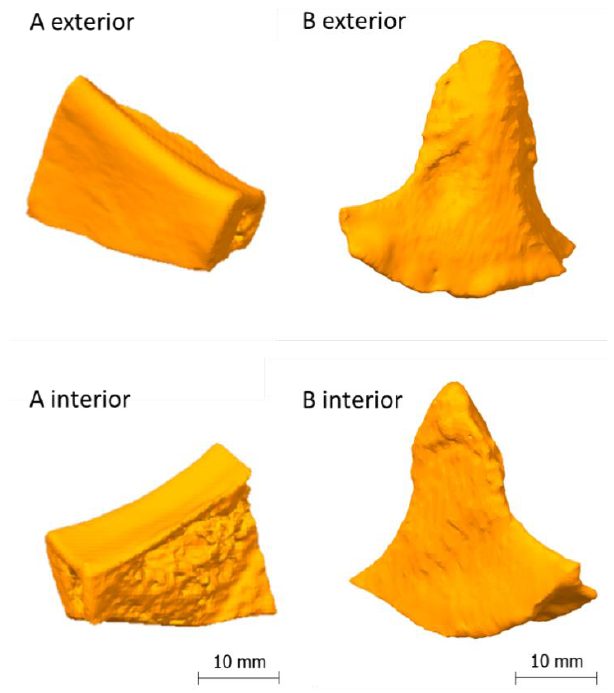
Figure 1. On the left side: model of implant A [7], on the right side: model of implant B.